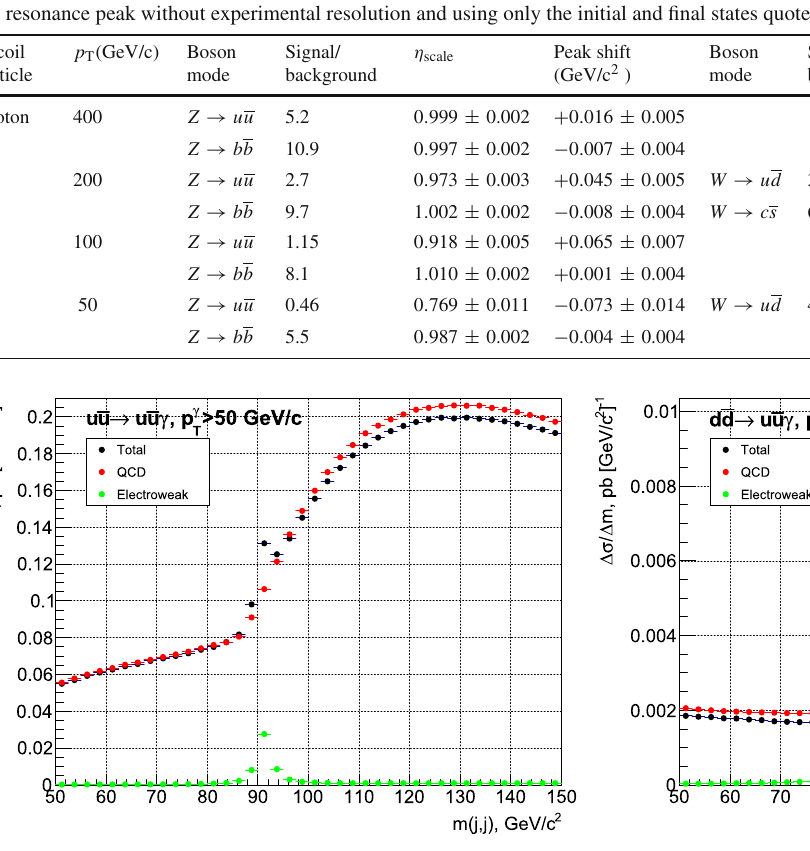
Fig. 10 The differential cross-section for the process qq → uu γ , with the u u pair required to have p T > 50 GeV/c. Left is uu → uu γ and right is dd → uu γ . The differential cross-section of pure electroweak is pale/green, pure QCD is dark/red and the total is black. The elec-